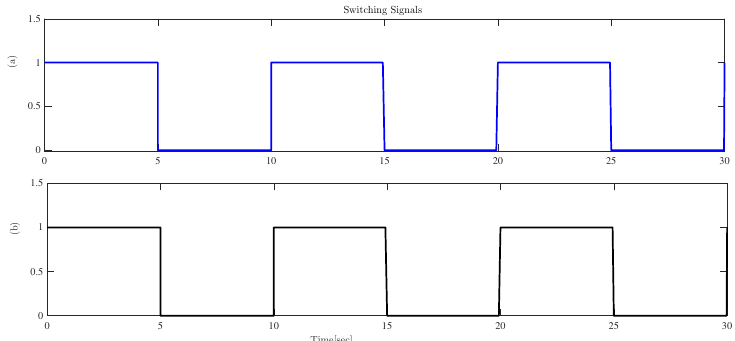
Figure 6. ( a ) Subsystem switching signal. ( b ) Observer switching signal.